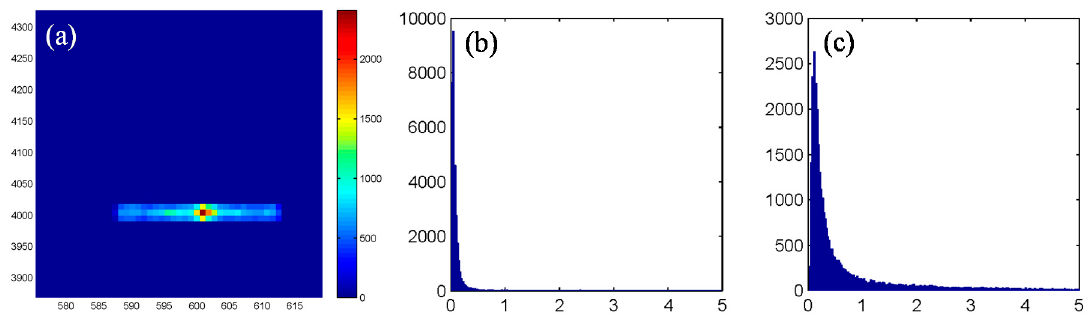
Figure 3. ( a ) An example of the 2D histogram of the statistical characteristic of the offsets; and ( b , c ) the histograms of standard errors of the range and azimuth offsets by using different window sizes, respectively. Appl. Sci. 2018 , 8 , x FOR PEER REVIEW